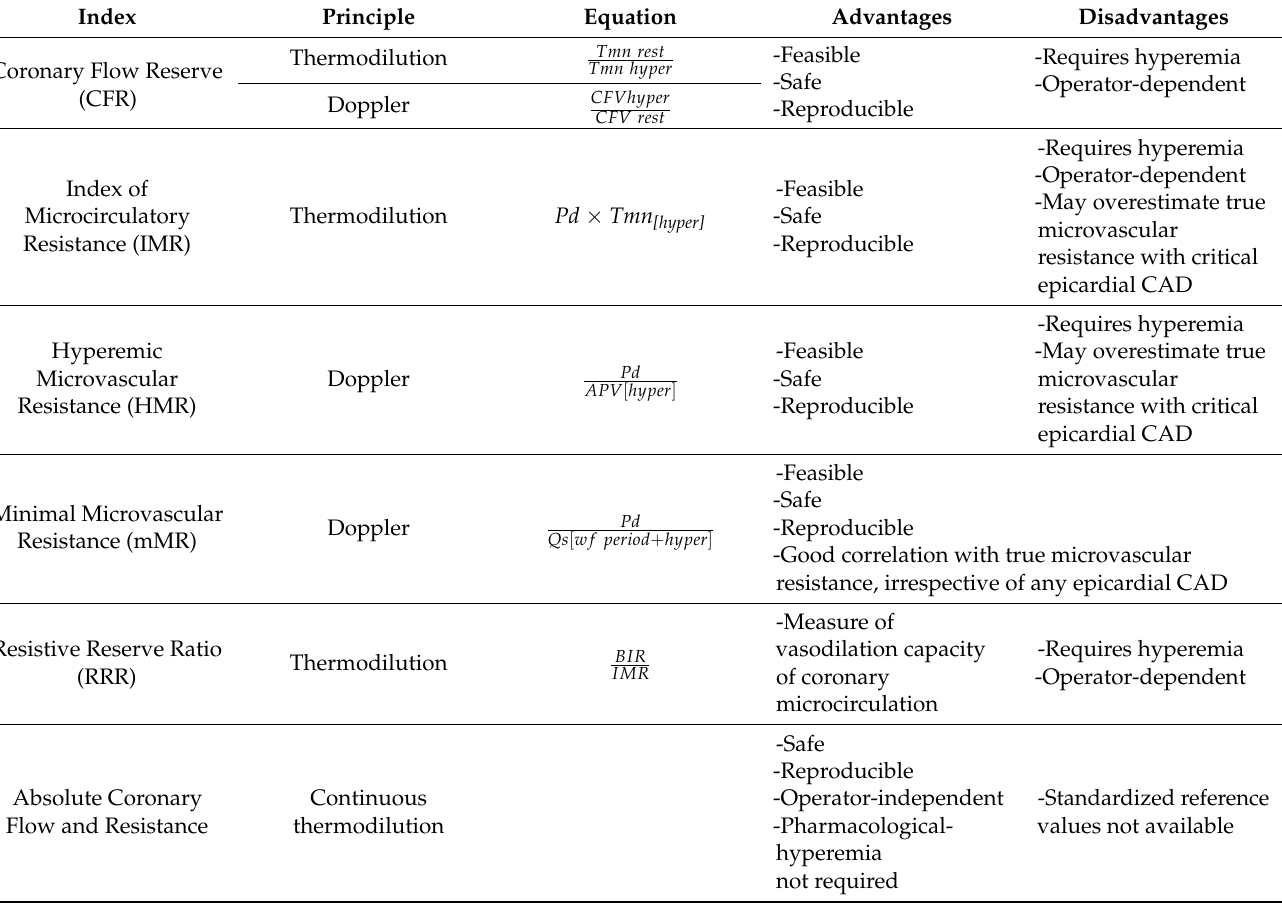
Table 3. Invasive methods of coronary microvascular function